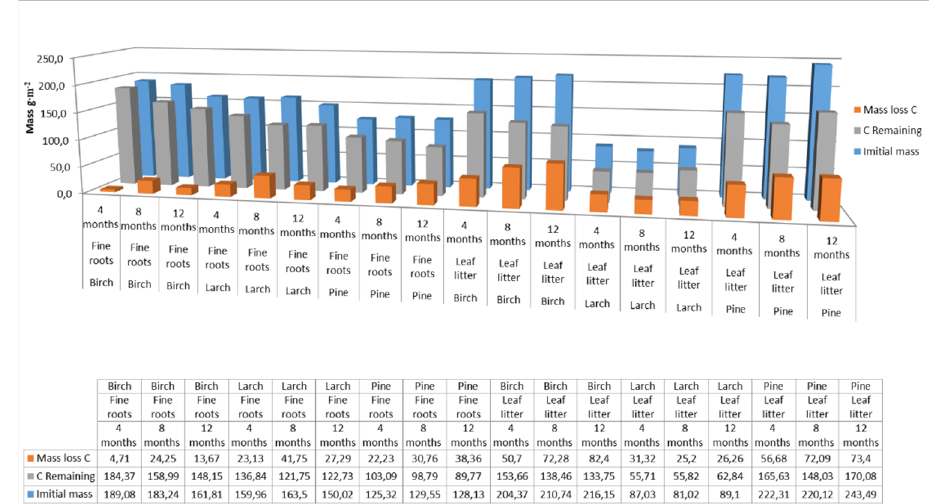
Figure 4. Carbon pool supplied to soils with fine roots and leaf litter at different decomposition times for different species. (Initial mass—the initial mass of carbon accumulated in fine roots or leaf litter at the end of the growing season; C Remaining—carbon accumulated in fine roots or leaf litter after 4, 8 or 12 months of decomposition; Mass loss C—loss of carbon from the fine roots or leaf litter after a specified decomposition time).